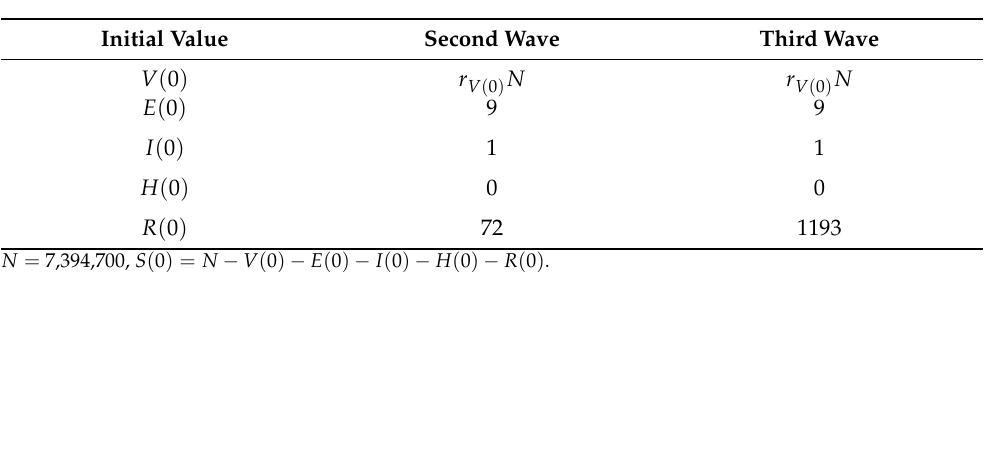
Table 2. Initial values for the second and third waves of COVID-19 in Hong Kong with vaccina- tion